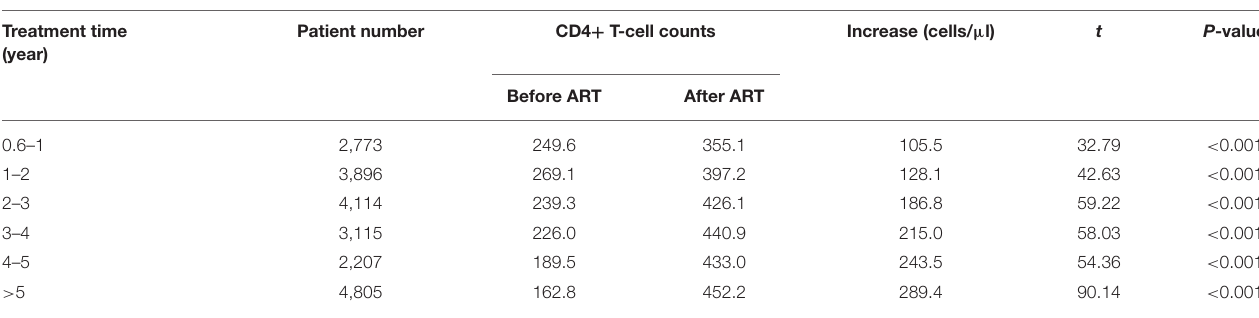
Treatment time Patient number CD4 + T-cell counts Increase (cells/ µ l) t P -value (year) Before ART After